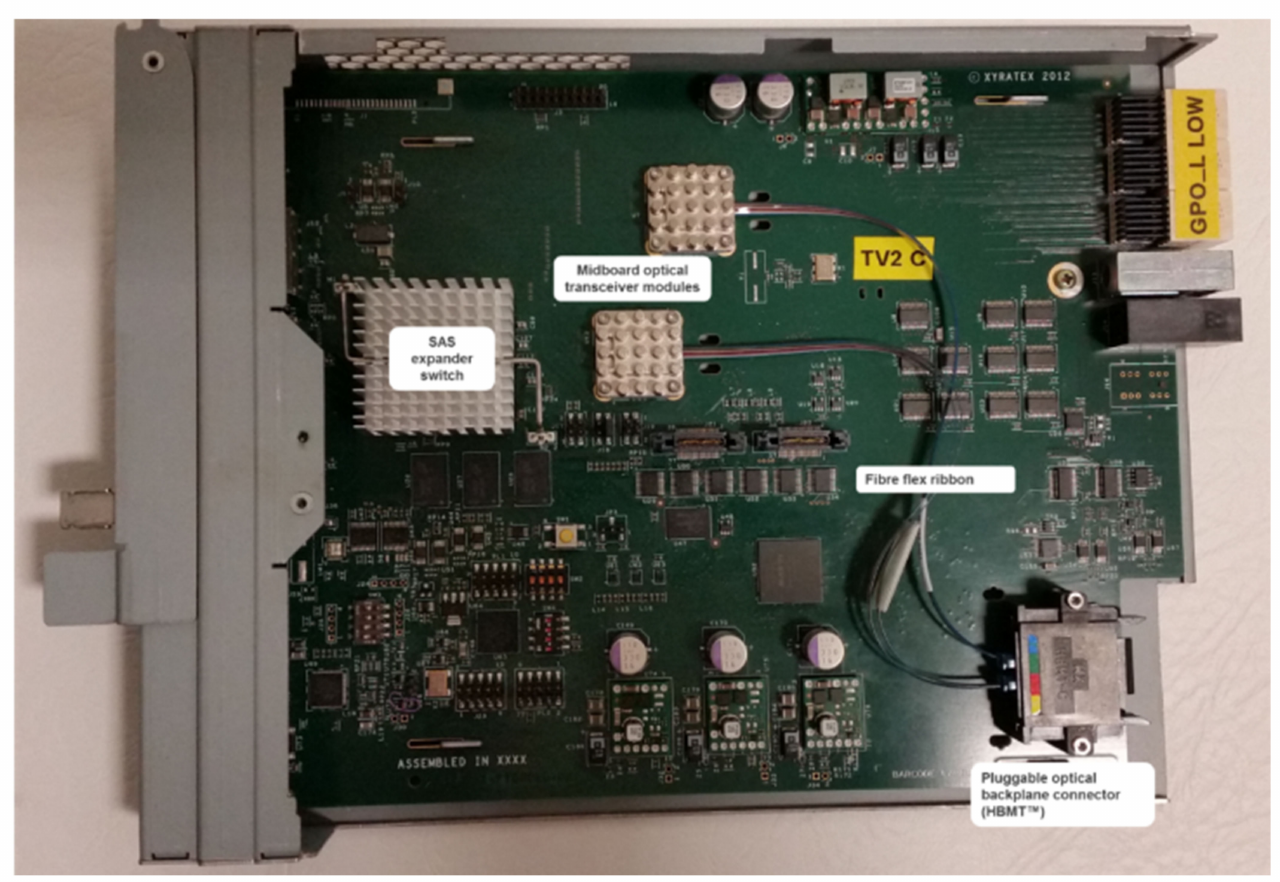
Figure 8. Optically enabled data storage controller